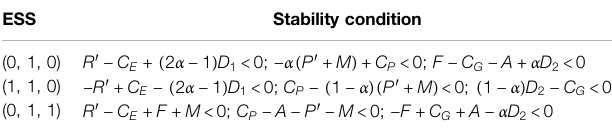
TABLE 4 | Stability conditions of equilibrium points in the evolutionary game. ESS Stability